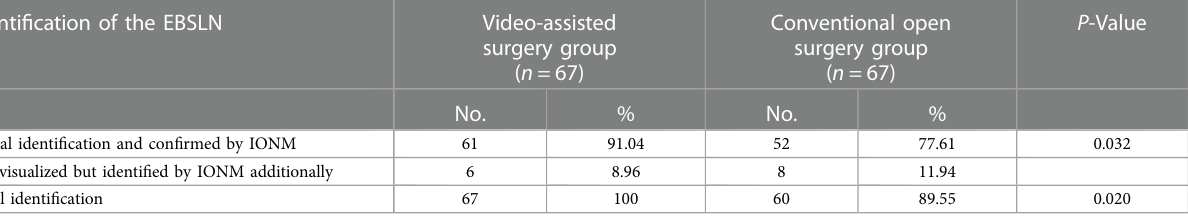
TABLE 2 Identi fi cation rate of the EBSLN in the VAS group and COS group. Identi fi cation of the